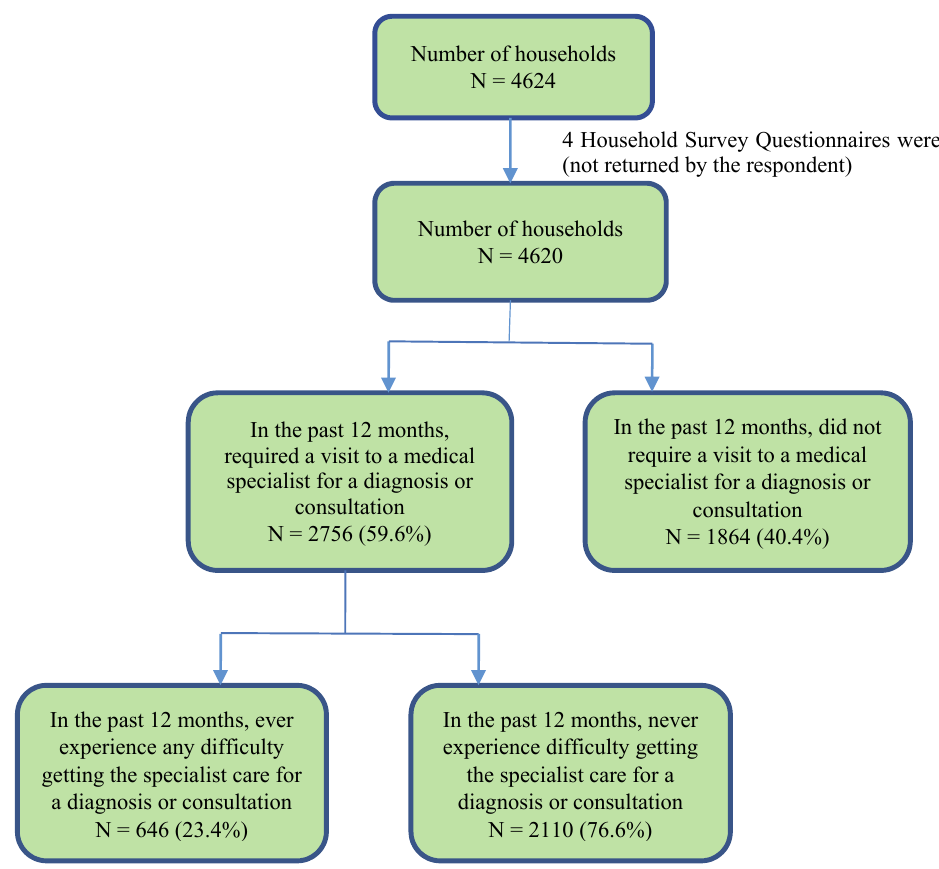
Figure 2. Sampling frame of access to specialist care in the past 12